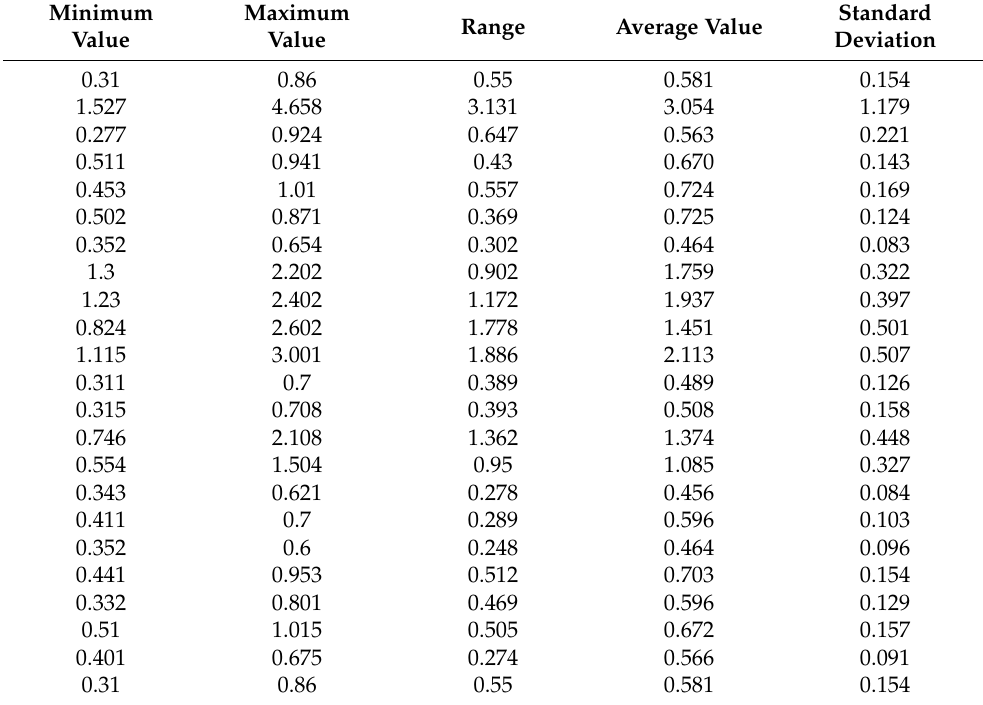
Table 7. Statistical parameters describing the differences between form deviations in subsequent cross-sections of each sphere from the second dataset (all values are given in micrometers).